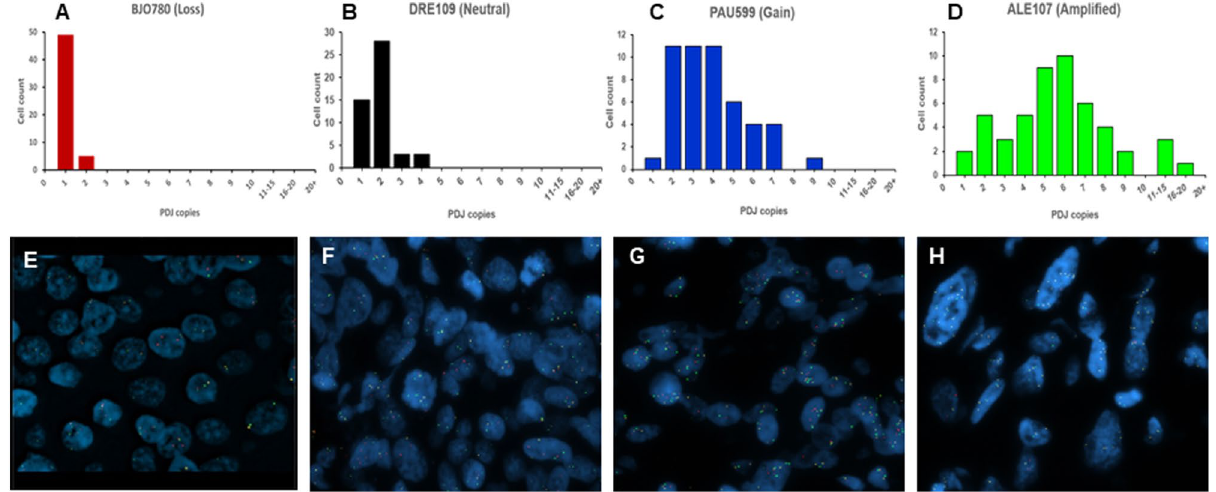
Figure 3. Distribution of PDJ amplicon copies per cell in PDJ- an PDJ + TNBC patient biopsies. ( A – D ) PDJ copy number was measured by FISH assay across 50 cells per sample in each TNBC biopsy. Average copy numbers ( x ) were used to define samples with deletions ( x < 2), no changes/neutral ( x = 4), gains (2 < x ≤ 4),